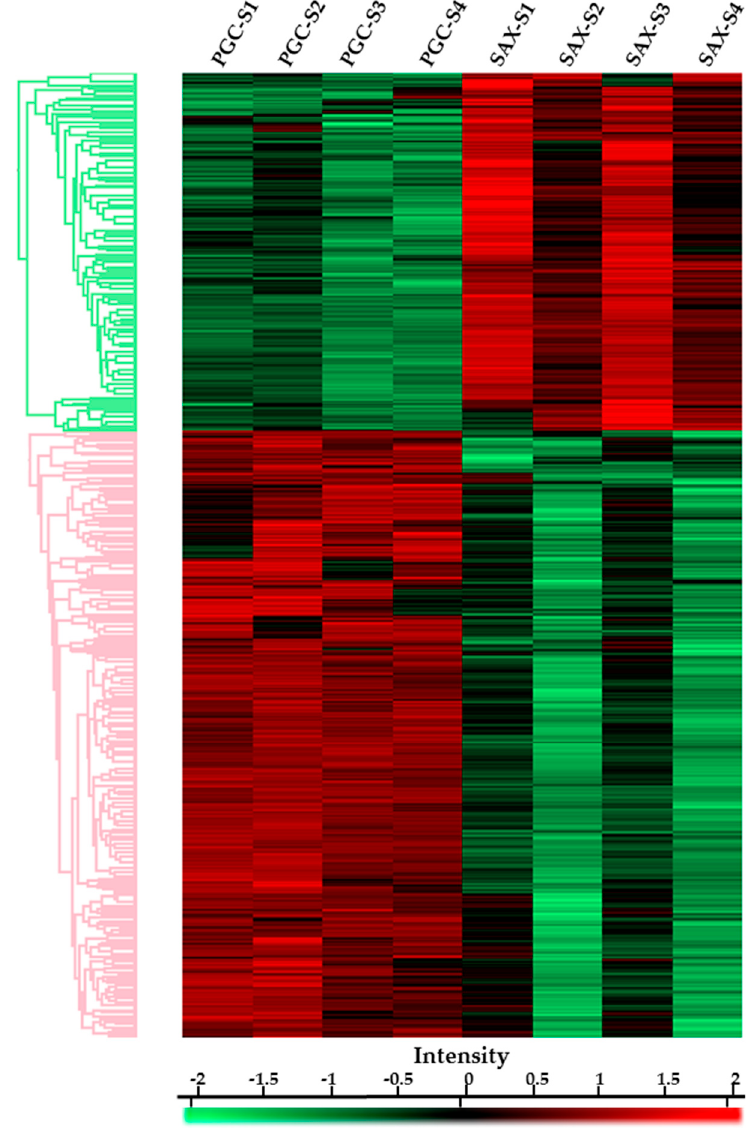
Figure 6. Heat map of the identified phosphosites. The heat map represents the significantly different phosphorylation sites identified after PGC or SAX fractionations. The phosphosites with increased intensities are marked in red, and phosphosites with lower intensities are marked in green.